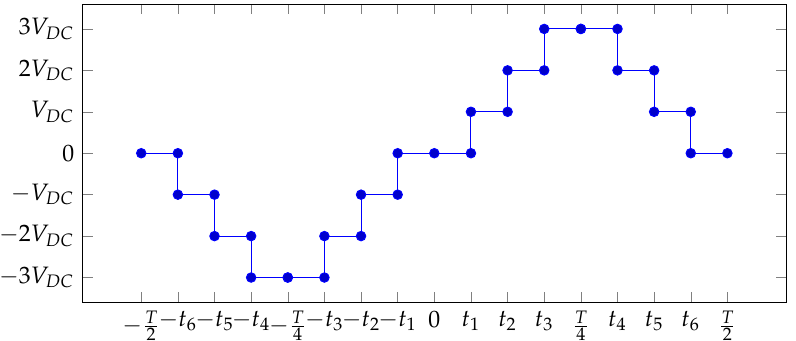
Figure 2. Output waveform for 7 levels